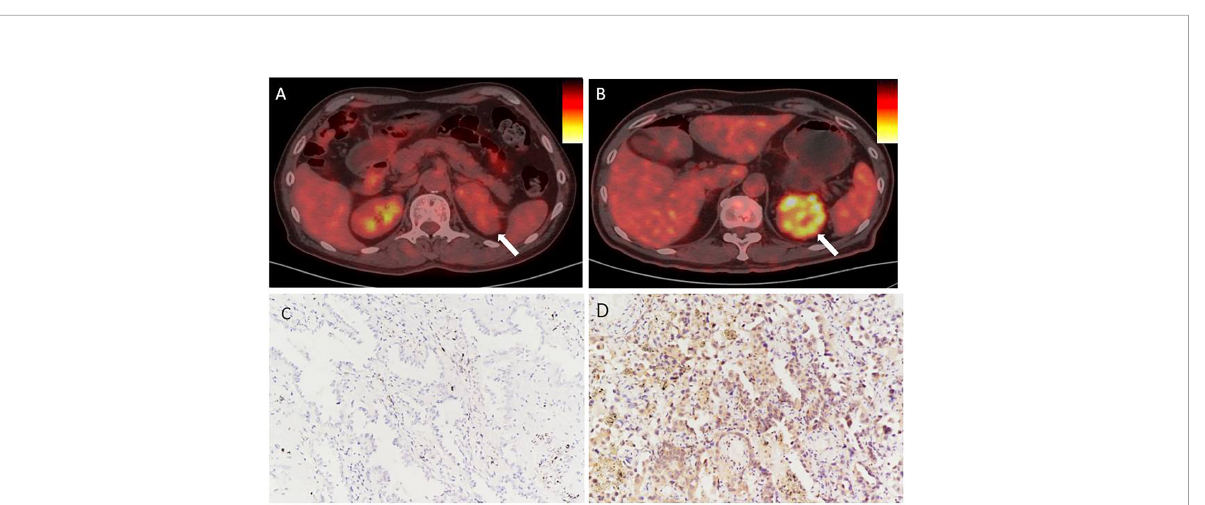
FIGURE 1 In renal cancer, there is an association between PD-L1 levels and SUVmax. (A, C) Negative staining for PD-L1 in a tumor from a 66 year man with CCRCC. The tumor lesion did not take up 18F-FDG obviously (SUVmax = 3.4, SUVmean = 1.9). (B, D) Strong positive staining for PD-L1 in a tumor from a 71 year old woman with CCRCC. The 18F-FDG PET/CT scan showed obvious accumulation of 18F-FDG in the tumor (SUVmax = 8.3, SUVmean = 3.5). IHC images were captured at 200× magni fi cation.